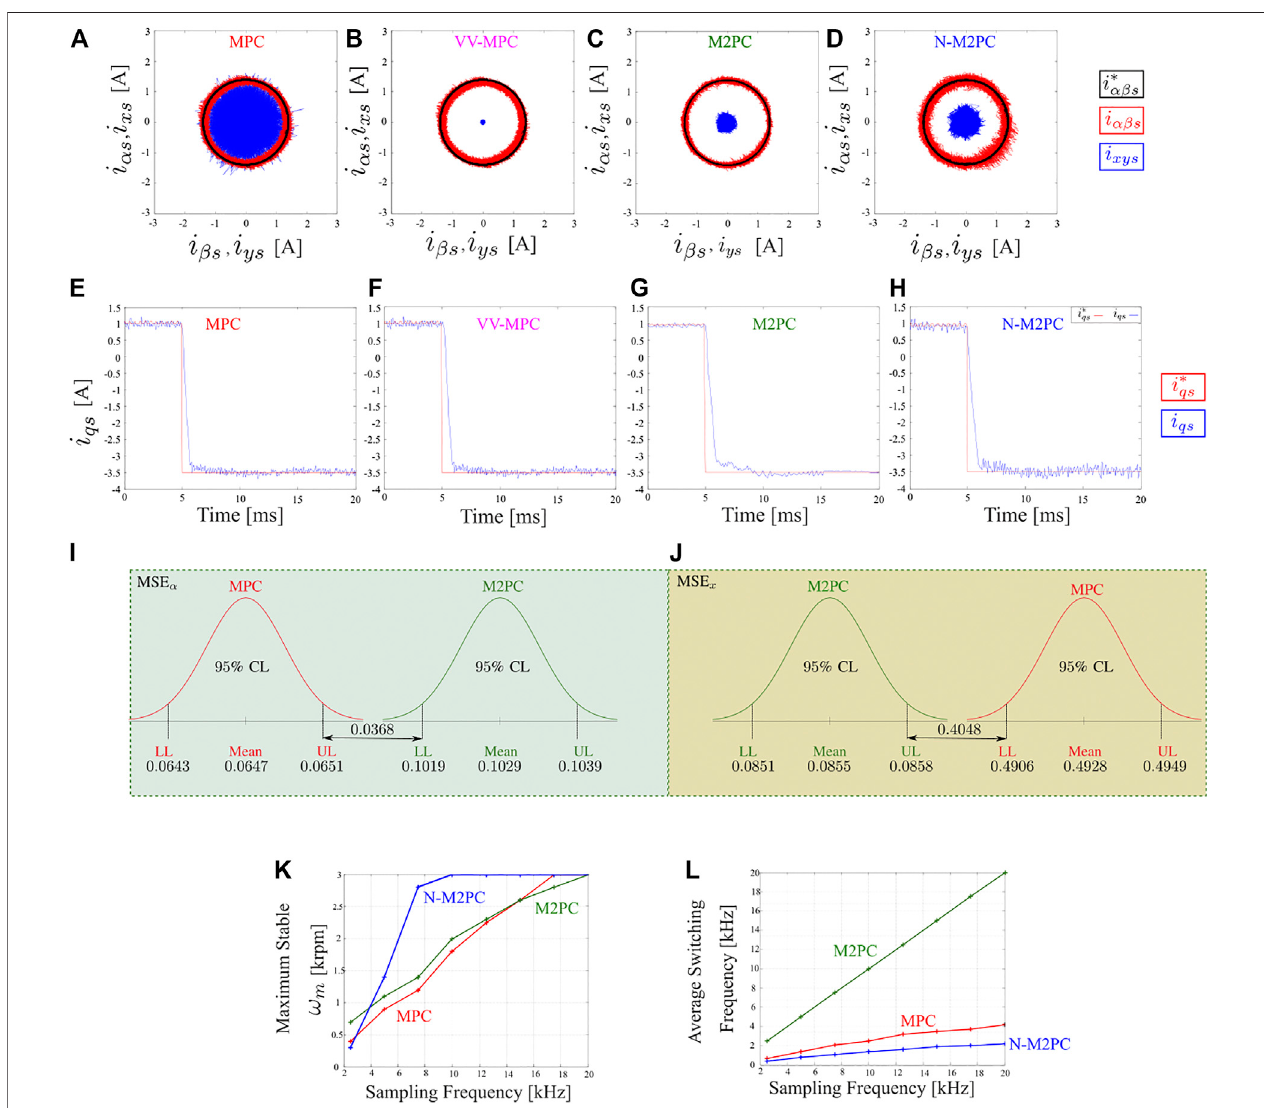
FIGURE 12 | Steady-state analysis: stator α − β and x − y currents in an asymmetrical six-phase IM fed by a dual three-phase VSC (A) classic MPC (Rodas et al., 2016), (B) Modulated-MPC (M2PC) (Gonzalez et al., 2019), (C) MPC with virtual vector (VV-MPC) (Gonzalez-Prieto et al., 2018) and (D) a Novel Modulated MPC (N-M2PC) (Ayala et al., 2021b). Transient-analysis: stator q -axis current: (E) classic MPC, (F) M2PC, (G) MPC-VV and (H) N-M2PC. Statistical comparison between MPC and M2PC (I) α -axis and (J) x -axis (Rivas-Martinez et al., 2021). Trend chart of classic MPC, M2PC and N-M2PC regarding different sampling frequencies and: (K) rotor mechanical speed; (L) average switching frequency (Ayala et al., 2021a).